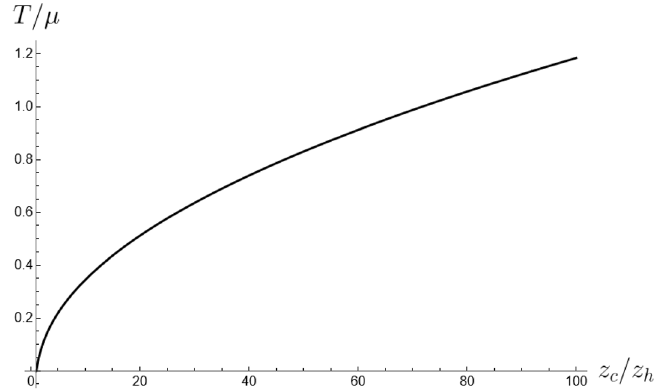
Figure 3 . T/µ as a function of z c /z h for the Reissner-Nordström AdS